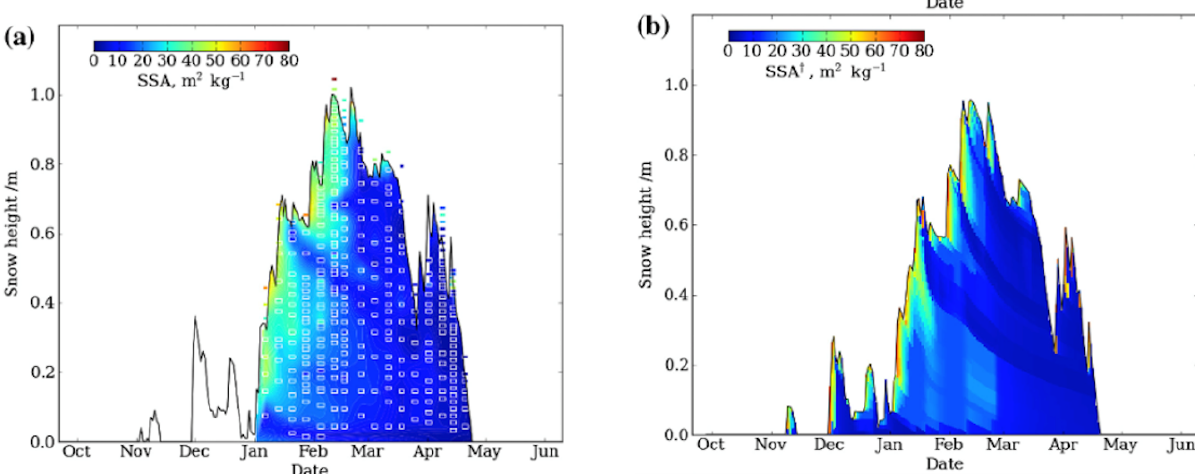
Figure 11. Observed and interpolated SSA observations (a) and SSA simulations (b) . From Morin et al. (2013). The small white marks are the